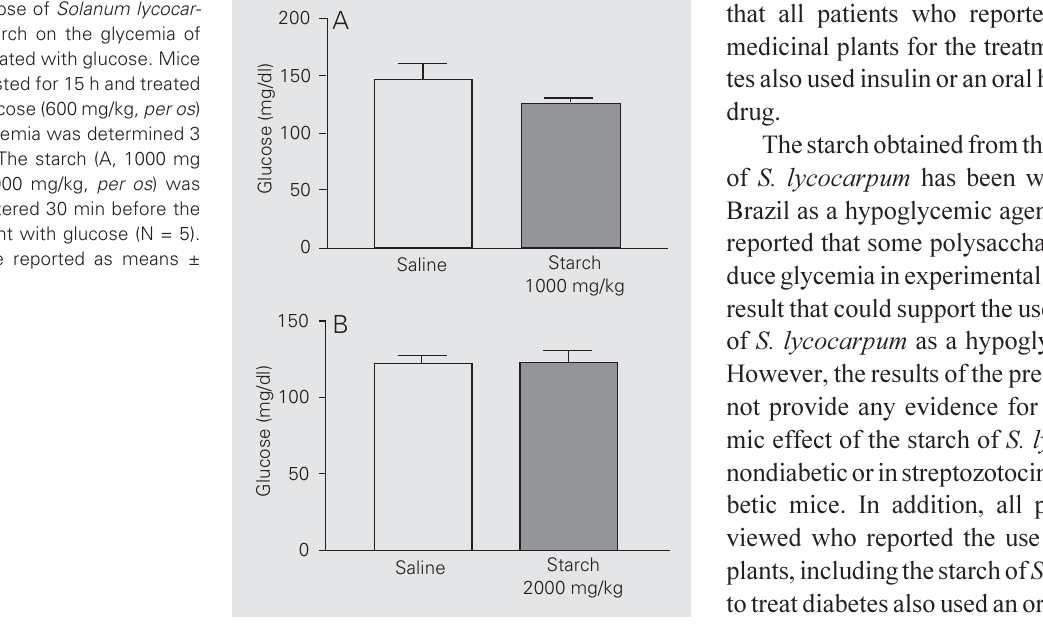
Figure 2. Lack of effect of a single dose of Solanum lycocar- pum starch on the glycemia of mice treated with glucose. Mice were fasted for 15 h and treated with glucose (600 mg/kg, per os